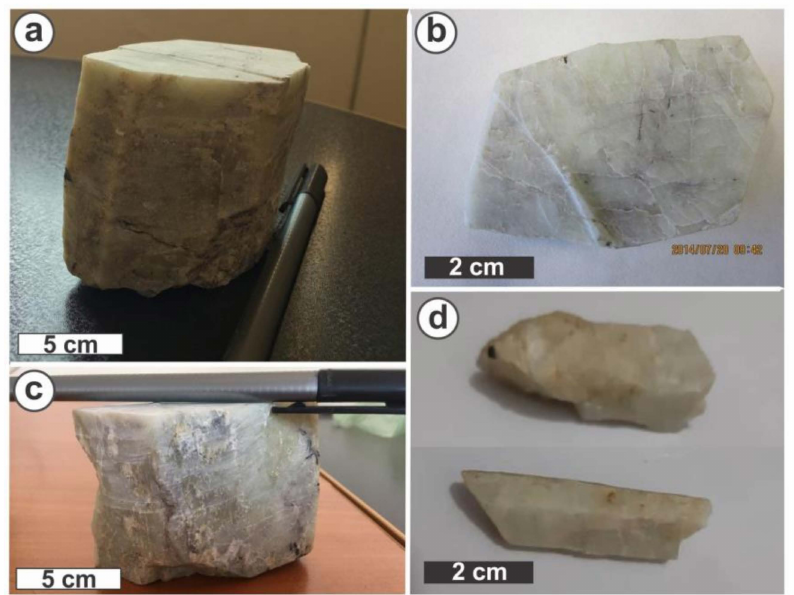
Figure 4. ( a – d ) Euhedral hexagonal prismatic crystal of beryl grains with pale-green to white colors in the Ebrahim-Attar granitic